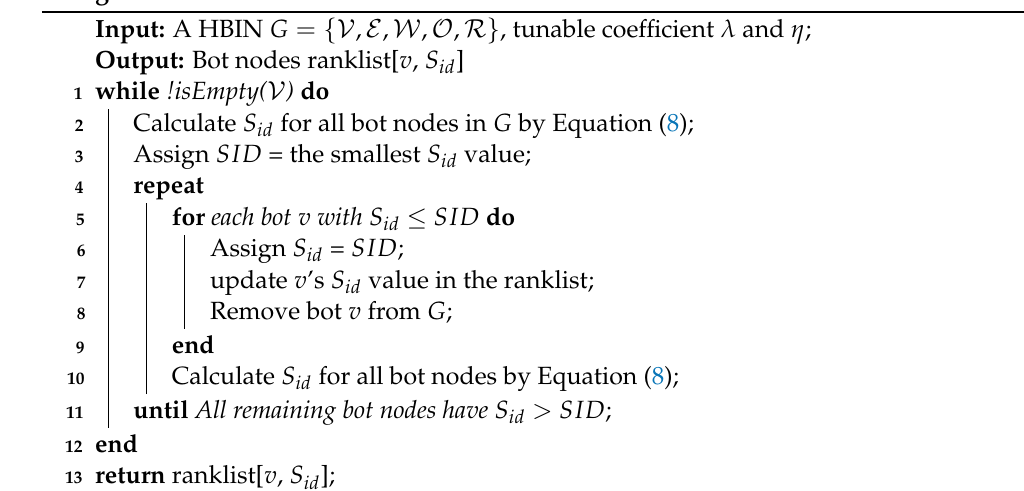
Algorithm 2: Infection diffusion score